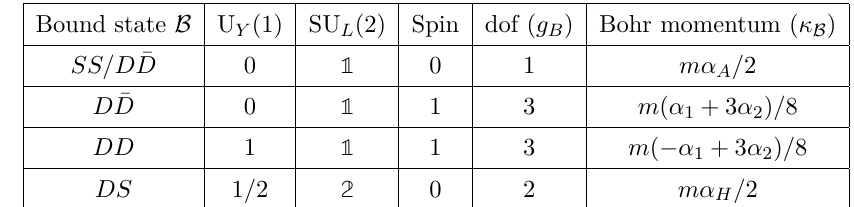
Table 2 . The ground-level (principal and angular-momentum quantum numbers { n‘m } = { 100 } ) bound states and their Bohr momenta κ κ 2 /m . The couplings are defined in eqs. (2.5) and (2.6). The SS/D B can decay directly into radiation. The DS rate of decay into radiation is suppressed, however the DS bound state can transit spontaneously into an SS/D ¯ D bound state via H emission. All other bound-to-bound transitions are suppressed. The bound state decay and transition rates are summarised in [35, table